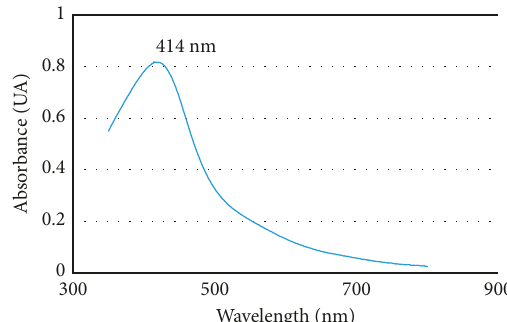
Figure 2: UV-Vis spectra of silver nanoparticles in optimal